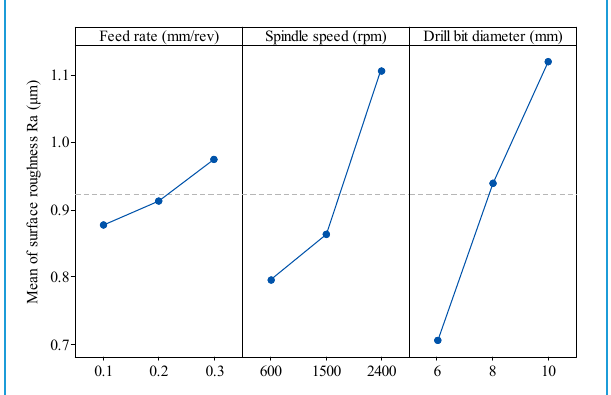
Figure 10. Main effects plot for the roughness (R a ).